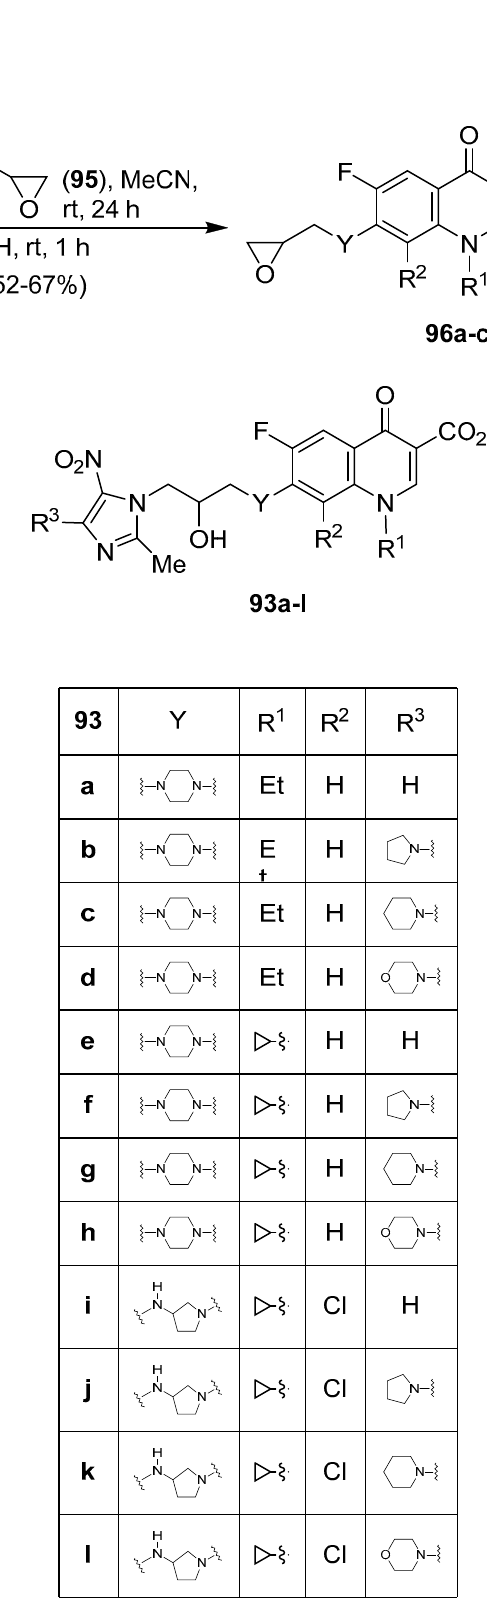
Scheme 18. Synthesis of quinolone/imidazole hybrids